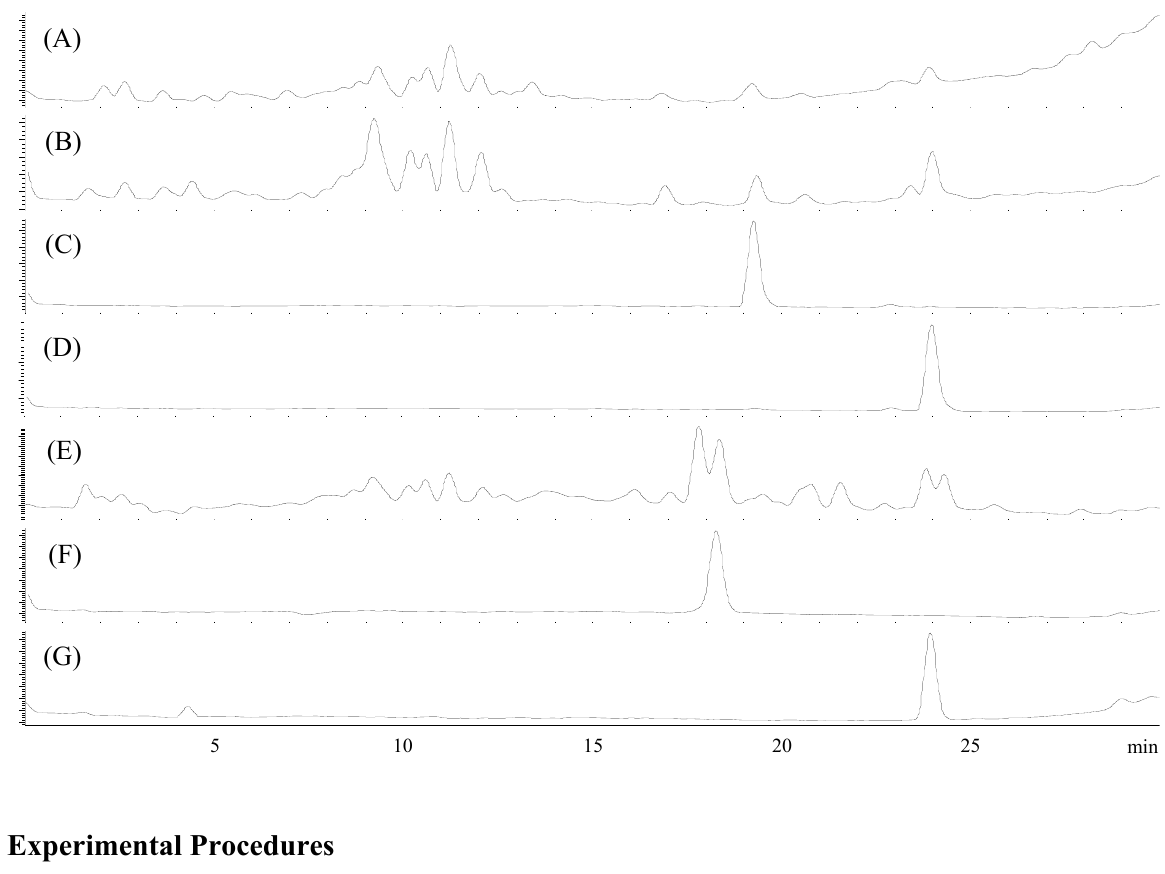
Figure 3. LC/MS chromatograms: ( A ) A1+C liquid medium, ( B ) Bacto peptone (Difco 211677) solution, ( C ) Cholic acid (Sigma C1129), ( D ) Deoxycholic acid (Sigma